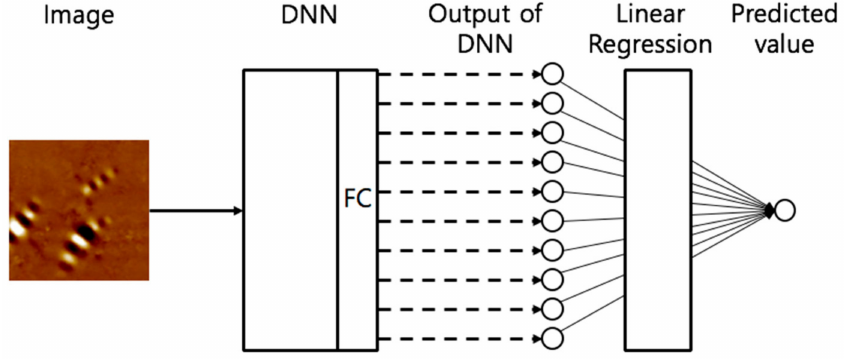
Figure 13. Conceptual architecture of group